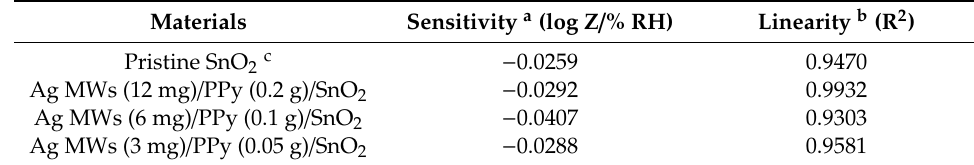
Figure 5. Impedance versus relative humidity for humidity sensors that were made of pristine SnO 2 and Ag MWs/PPy/SnO 2 in various compositions. Table 1. Sensitivity and linearity of impedance-type humidity sensors that were made of pristine SnO 2 and Ag MWs/PPy/SnO 2 ternary composite films